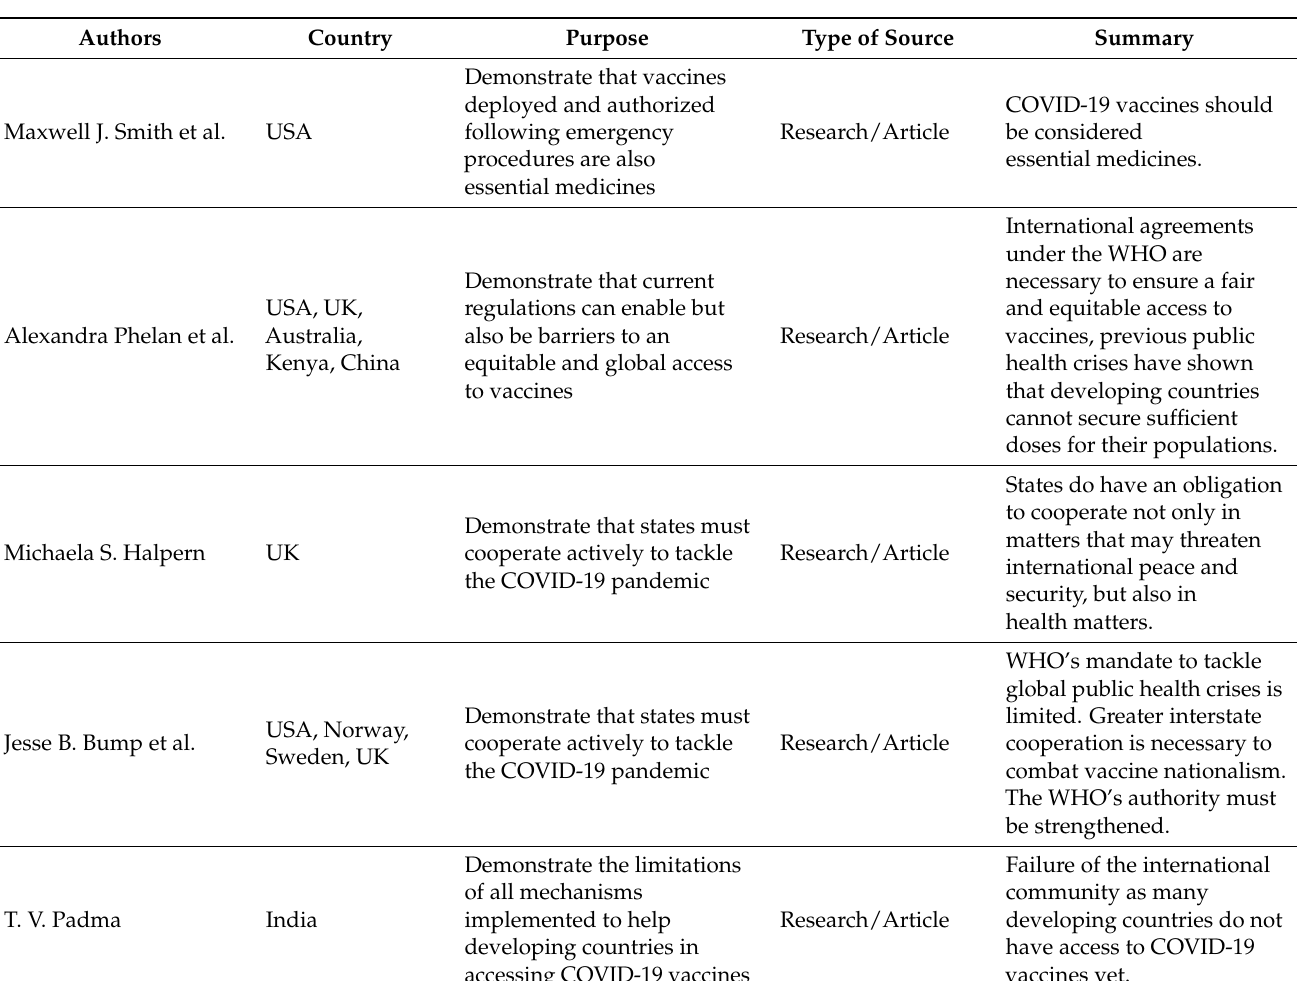
Table 2. Overview of the reviewed